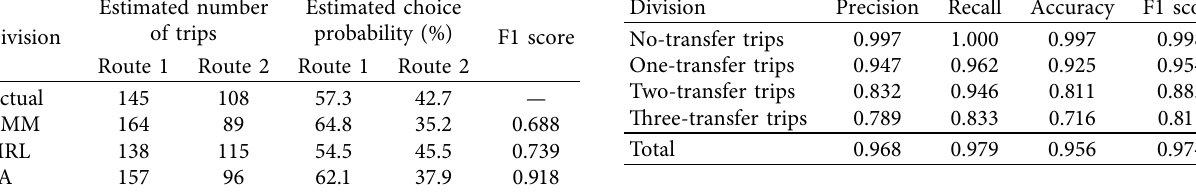
Table 4: Travel route estimation result of the comparison models. Estimated number Division